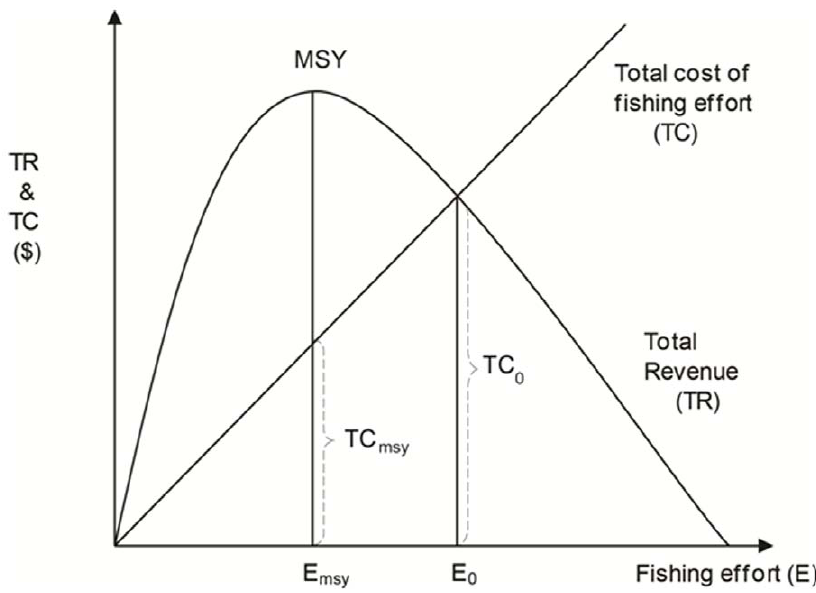
Figure 5. The Schaeffer surplus-production model, based on Gordon [ 27 ] .